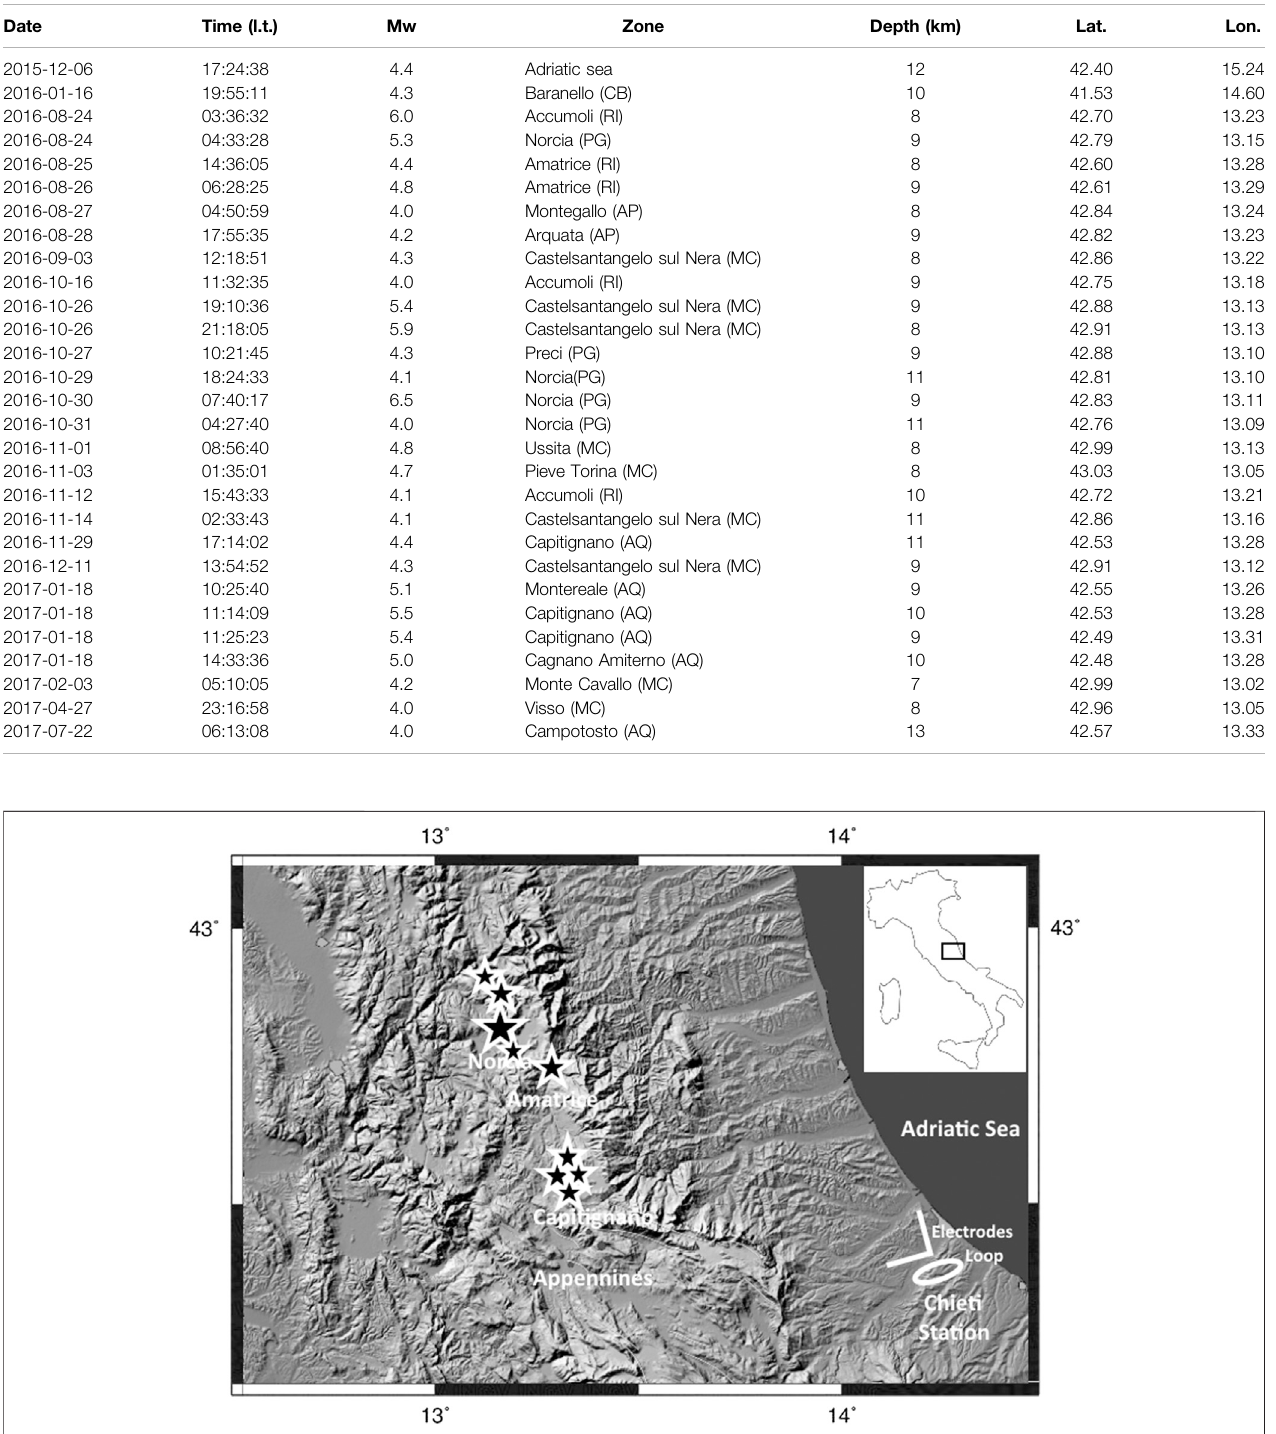
Frontiers in Earth Science |